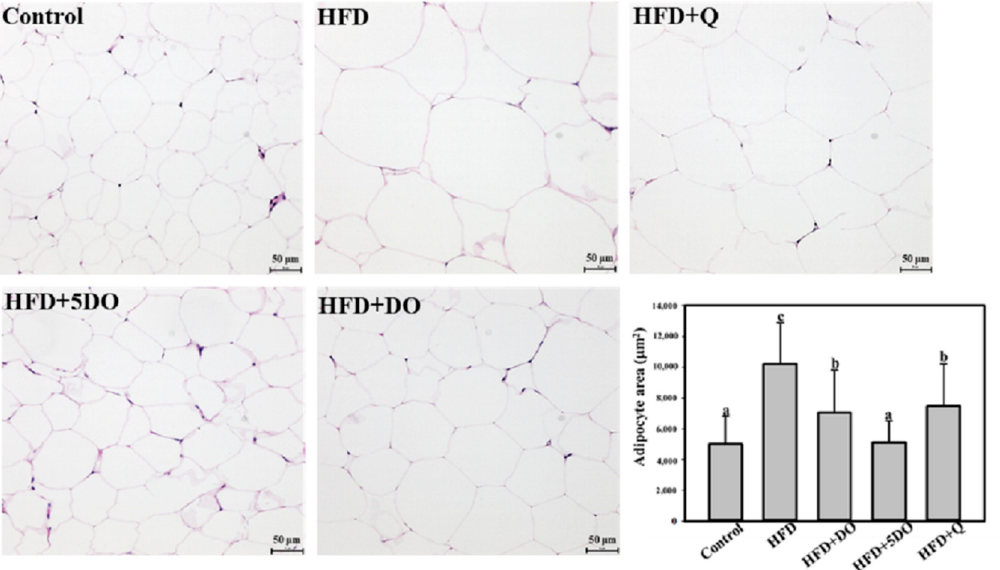
Figure 1. Effect of dried onion powder and quercetin on the HE staining images and the quantitative level of adipocyte area in epididymal adipose in rats exposed to HFD. The animals were treated with a high fat diet (HFD) along or supplemented with dried onion powder (1% or 5%; DO and 5DO, respectively) or quercetin (Q) for 12 weeks. The control group was given the control diet. Values (mean ± SD) not sharing a common letter are significantly different ( p < 0.05). Scale bar, 50 μ m.